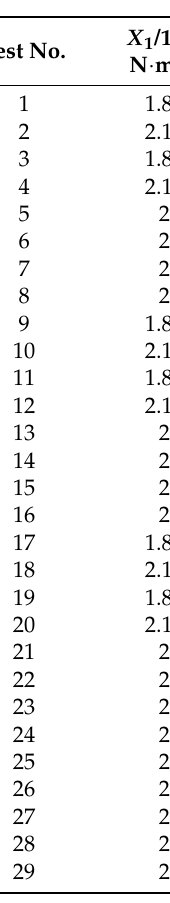
> X 1 and X 4 > X 1 > X 5 > X 2 , respectively. The lack of fit of the regression model p = 0.1597 > 0.05 and p = 0.1013 > 0.05 were not significant. The functional relation between Y 1 and the significant factors was Equation (10). The R 2 and adjusted R 2 of the regression model were 0.978 and 0.956, respectively. The functional relation between Y 2 and the significant factors was Equation (11). The R 2 and adjusted R 2 of the regression model were 0.939 and 0.878, respectively. It indicated that the fitting model was reliable.